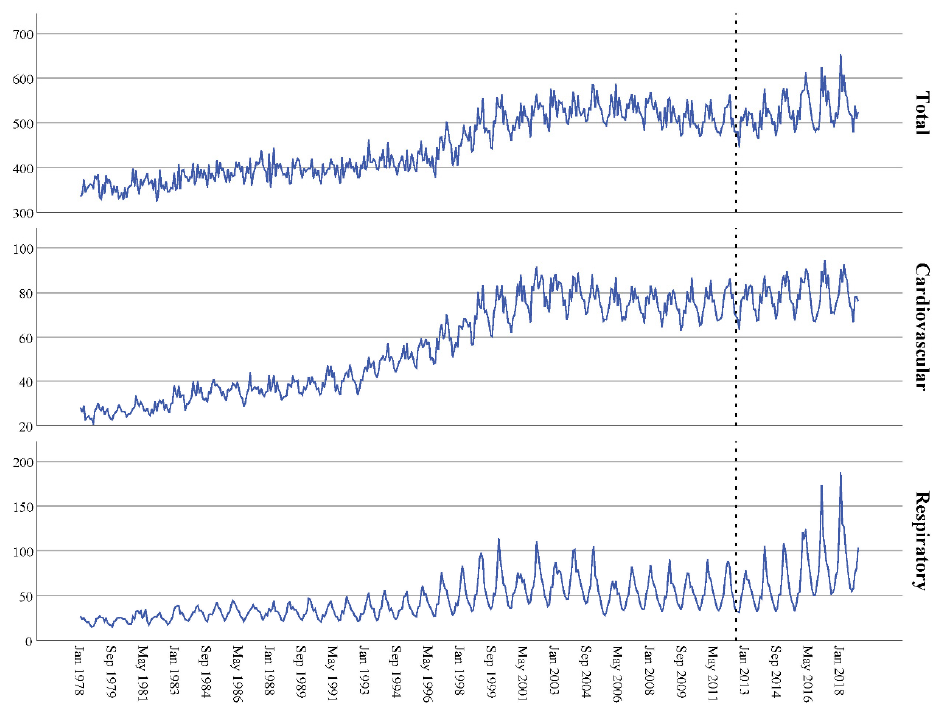
Figure 1. Time series for the number of hospital admissions per 100,000 inhabitants in Spain: 1978–2018 data. The dotted line indicates when the copayment system was implemented. The top figure corresponds to all-cause admissions, the middle figure to cardiovascular admissions and the bottom figure to respiratory admissions.